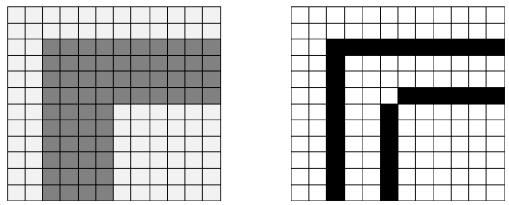
Figure 1. Detection of border pixels by comparison with their immediate environment